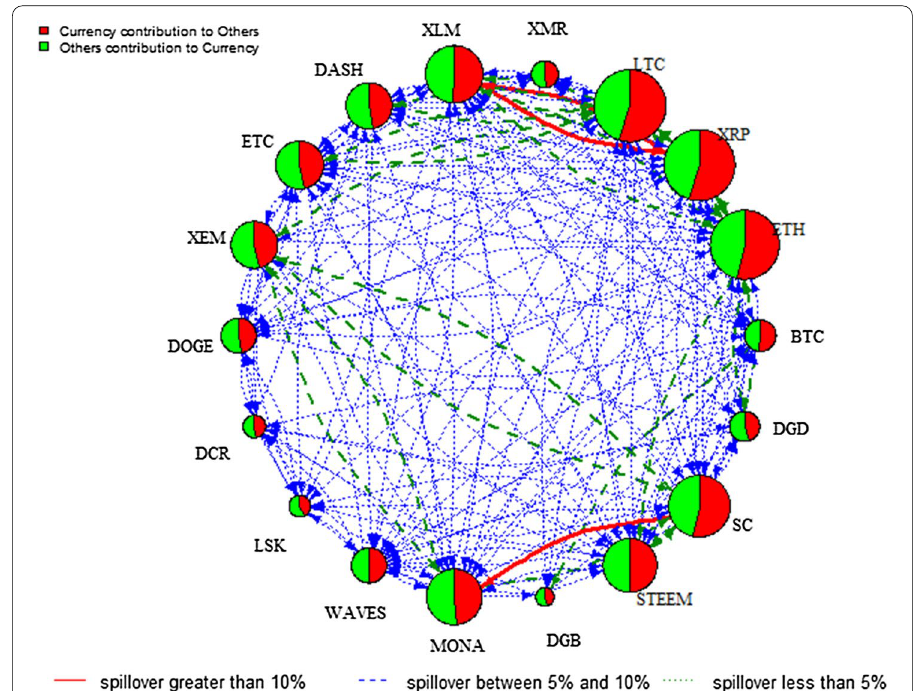
Fig. 7 DY Spillover network—low volatility regime of COVID19. Note : See notes to Fig. 2